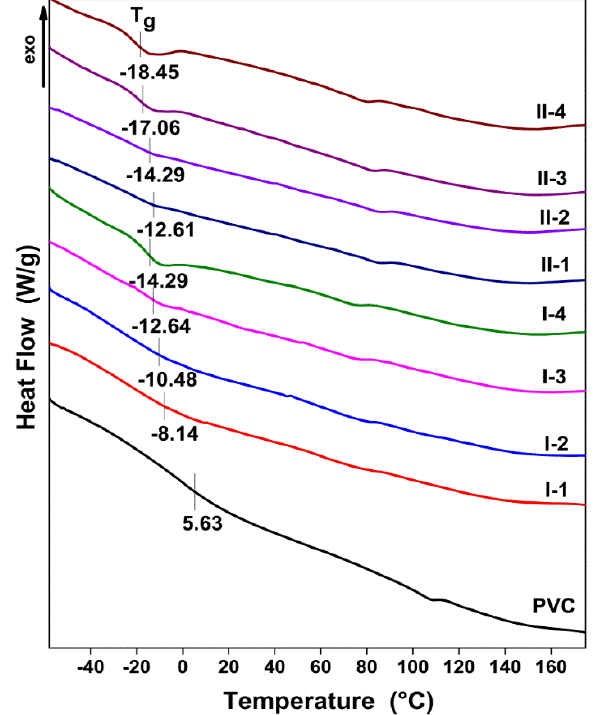
Figure 10 . DSC 2nd heating curve of PVC compound and PVC composites. Figure 10. DSC 2nd heating curve of PVC compound and PVC